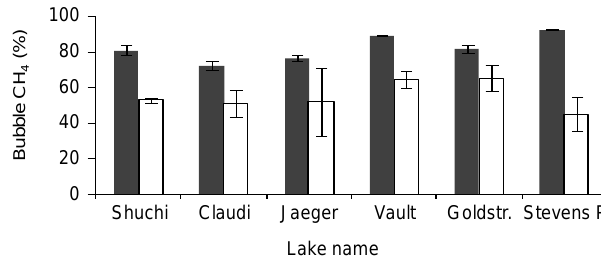
Figure 3. Average CH 4 concentrations in ebullition bubbles col- lected at the lake surface before interaction with lake ice (“fresh bubbles”, grey bars) and in ebullition bubbles trapped by the lake ice (white bars). Error bars represent standard error for n = 2 to 41 seeps per lake. Among lakes, CH 4 concentrations in ice- trapped bubbles were 33 ± 12% lower than in fresh bubbles (Mann– Whitney U test, Z > 1.96, p < 0.05).